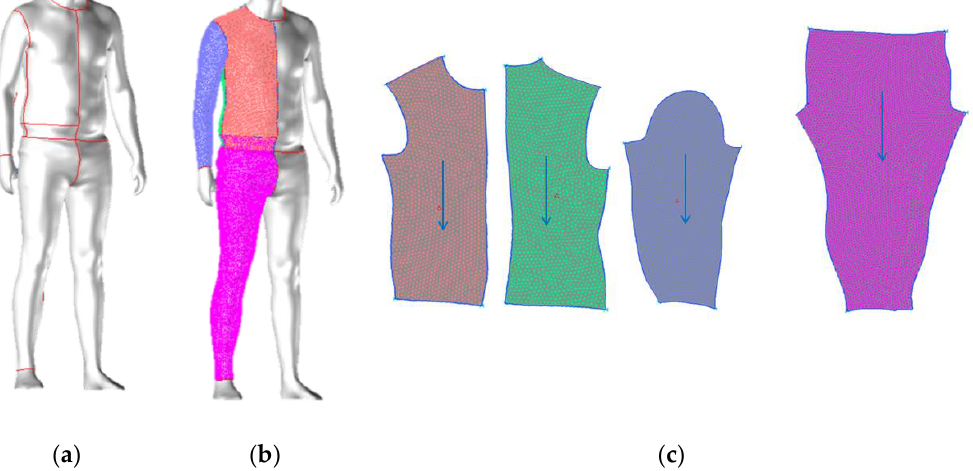
Figure 2. ( a ) Drawing of the region curves, ( b ) feneration of triangulated meshes, and ( c ) 2D patterns of long sleeve shirt and trousers generated by the flattening process .